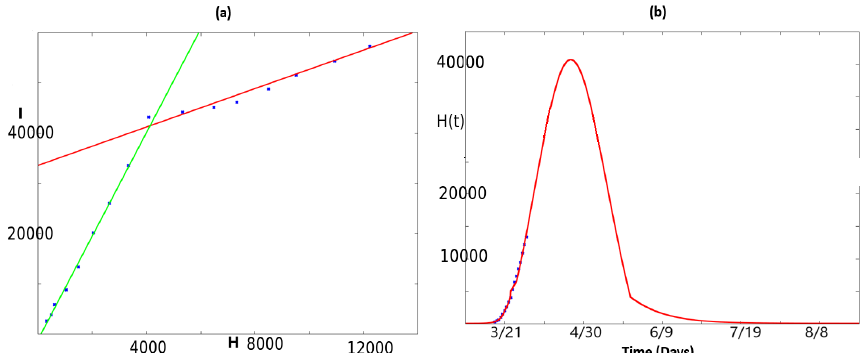
Figure 2. This figure illustrates how to provide an estimation for people needing hospitalization thanks to Equation (2) and statistical methods. Panel ( a ) illustrates an approximation of I ( t i ) , t i ∈ { 16,17,...,32 } by a vector ( a 1 H ( t i ) + b 1 ) , t i ∈ { 16,17,...,23 } and another vector ( a 2 H ( t i ) + b 2 ) , t i ∈ { 24,25,...,32 } where a j and b j , j ∈ { 1,2 } are the coefficients obtained thanks to the least-square method. Panel ( b ) then provides a prediction of people in need of hospitalization by plotting the quantity H ( t ) = I I ( t ) ≥ 41,475.76, H ( t ) = I ( t ) − b 1 a